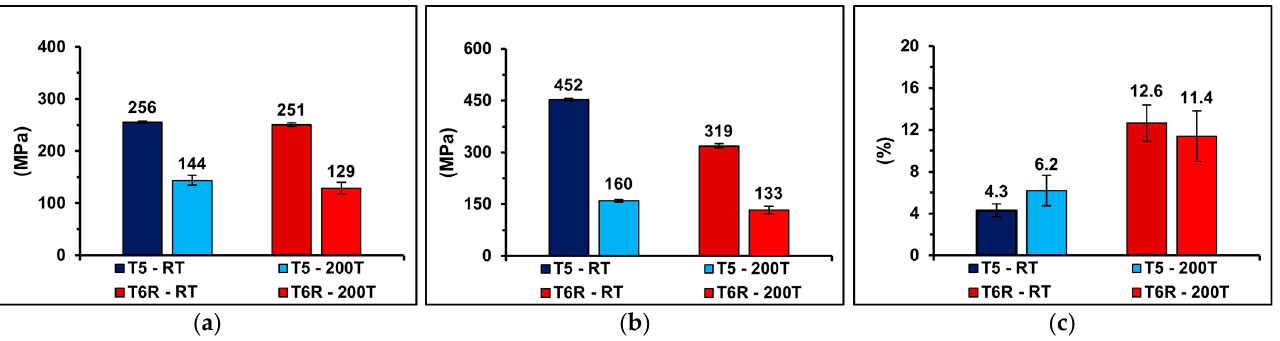
Figure 8. Tensile properties (YS ( a ), UTS ( b ), and e f ( c )) of the T5 and T6R alloys tested at room temperature (T5 ‐ RT and T6R ‐ RT) (i) and 200 °C (T5 ‐ 200T and T6R ‐ 200T) (ii). T ‐ bars represent the standard deviation of YS, UTS, and e f . More details about tensile characterization are available in